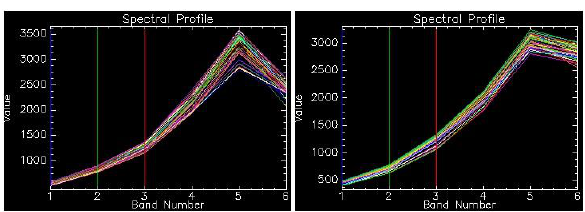
Figure 4. Dry season true colour image of the study area.